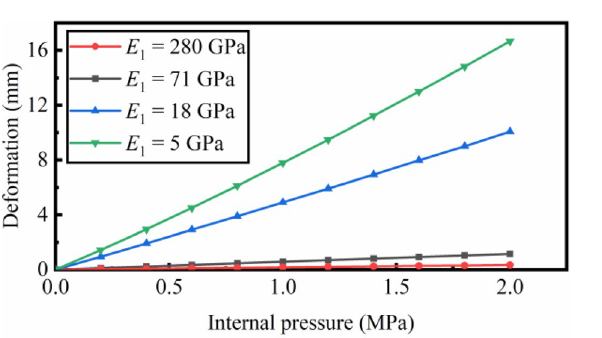
Figure 10. ( a ) The lower limit of available winding trajectoreis with different a / L 2. ( b ) The upper limit of the initial winding angle with different slippage coefficient.